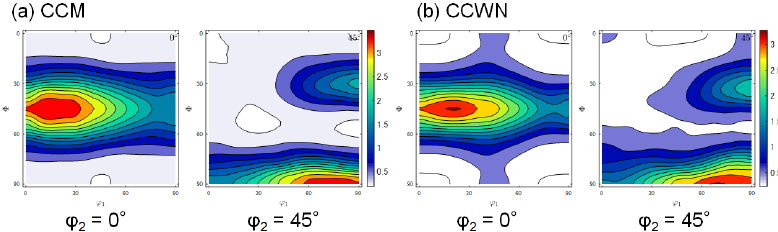
Figure 3. Orientation distribution functions (ODFs) for 40% rolled ( a ) CCM and ( b ) CCWN alloys. Contour lines are drawn with 0.25 increment of orientation densities.